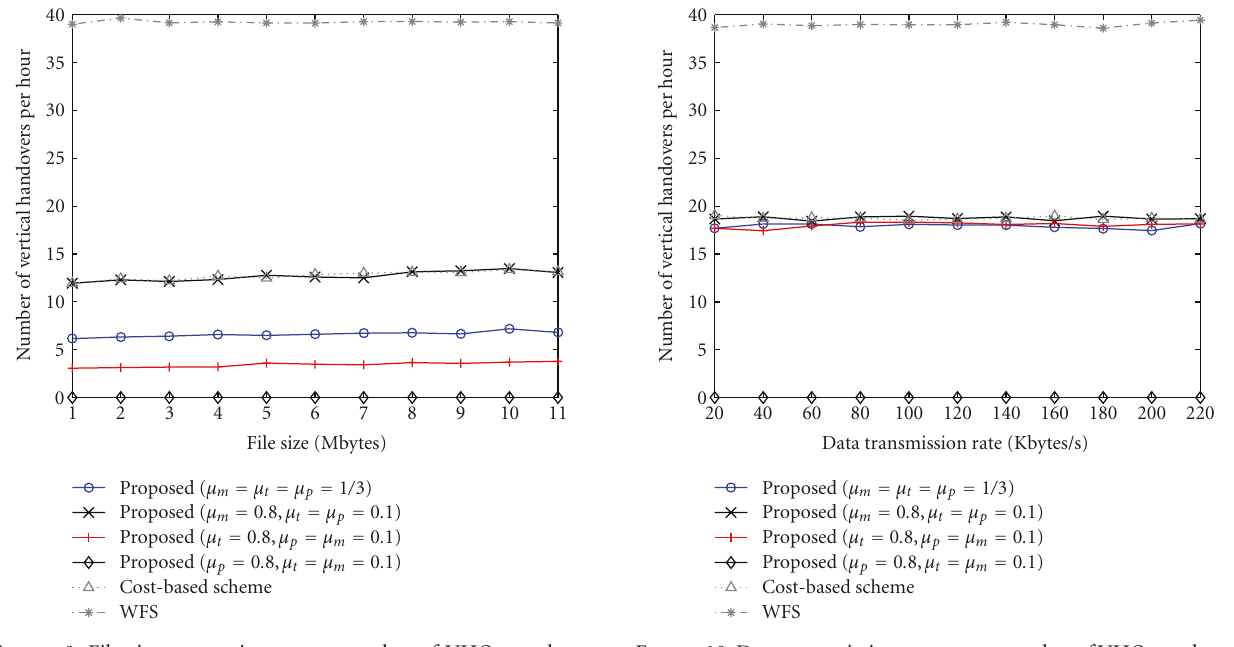
Figure 8: File size per session versus number of VHOs per hour when the TCP tra ffi c ( ρ = 1) is generated.